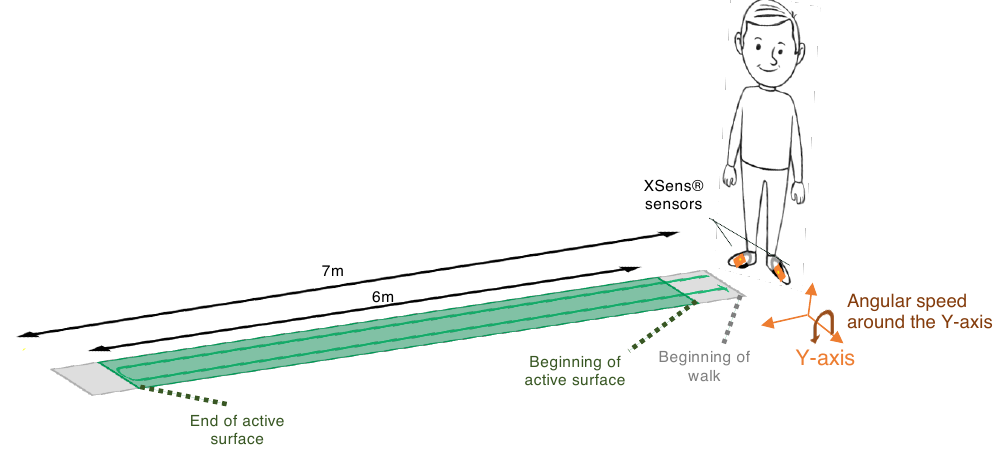
Figure 1. Measurement protocol. The XSens ® sensors (XS) inertial measurement units and the GaitRite ® mat (GR) are synchronized by using the PC clock connected to the inertial measurement units. The active surface (green) is covered with pressure sensors. The rest of the mat (grey) is inactive and does not detect any pressure from the